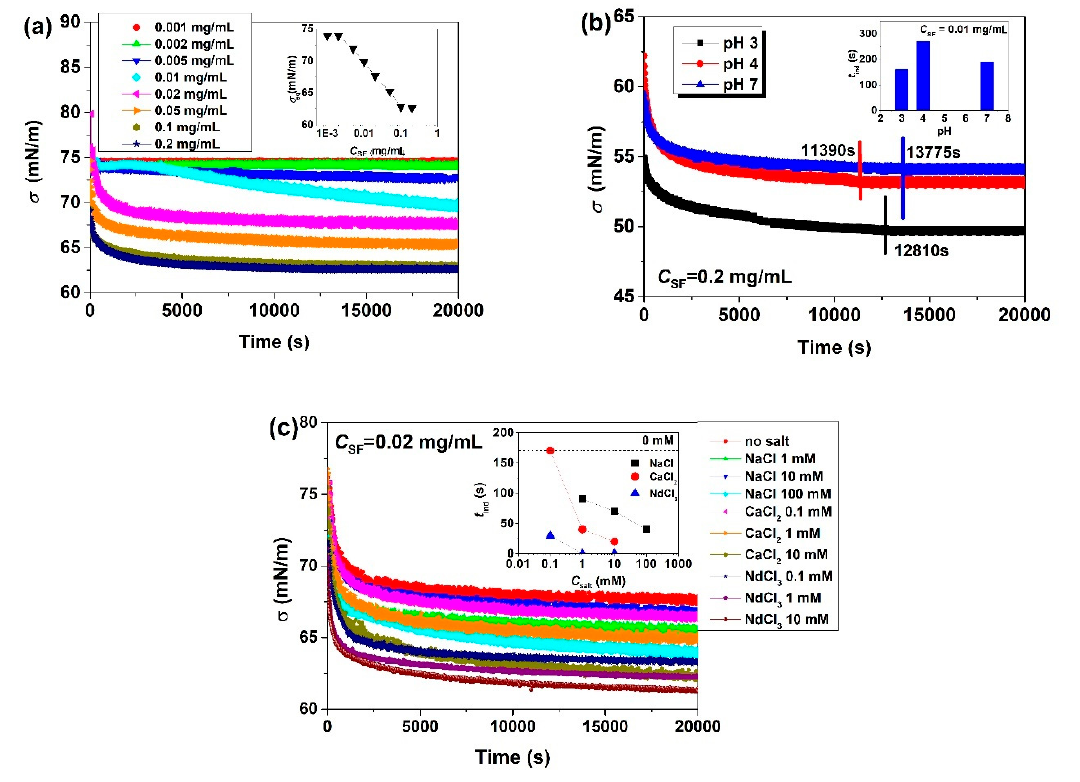
Figure 3. Influences of solution conditions on the surface tension ( σ ) of SF solutions at the air/water interface: ( a ) influences of C SF ; ( b ) influences of pH; ( c ) influences of salts. The inset plots are the effects of C SF , pH and C salt on the equilibrium surface tension ( σ eq ) and induction time ( t ind ) (taken from